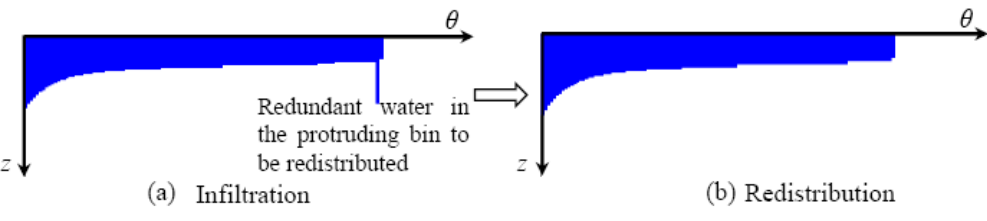
Figure 4. A numerical example: ( a ) infiltration and ( b ) redistribution.